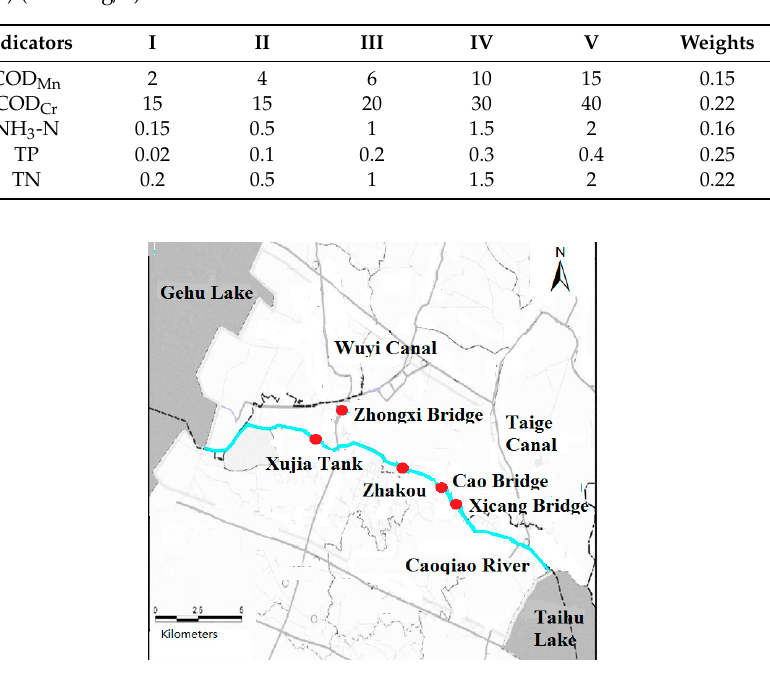
Table 1. Upper boundary values of indicators in environmental quality standards for surface water (GB3838-2002) (unit: mg / L).